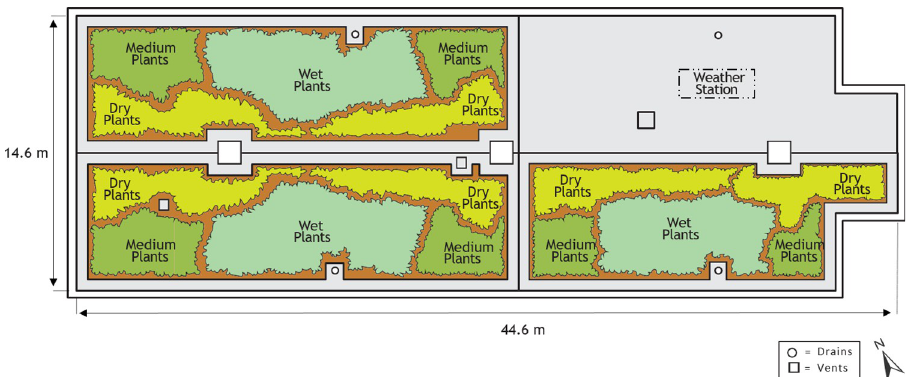
Fig 2. Wet, medium moisture, and dry planting zones on the Ranaqua green roof.